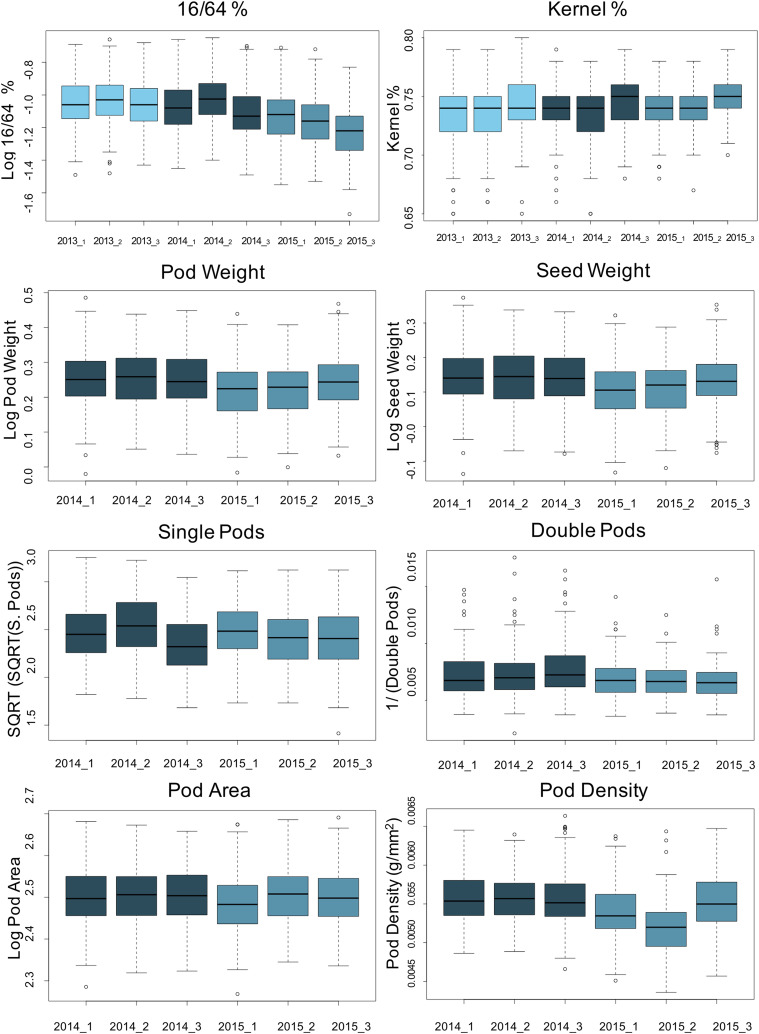
Boxplots for seed and pod traits across years, blocks and replicates within years, based on the normalized data. y-axis indicates the original metric or the normal-transformed of the trait value and the x-axis the years and replicates within a year. The color of the boxes indicates different years. Light sky blue 2013; dark blue, 2014, teal blue, 2015.